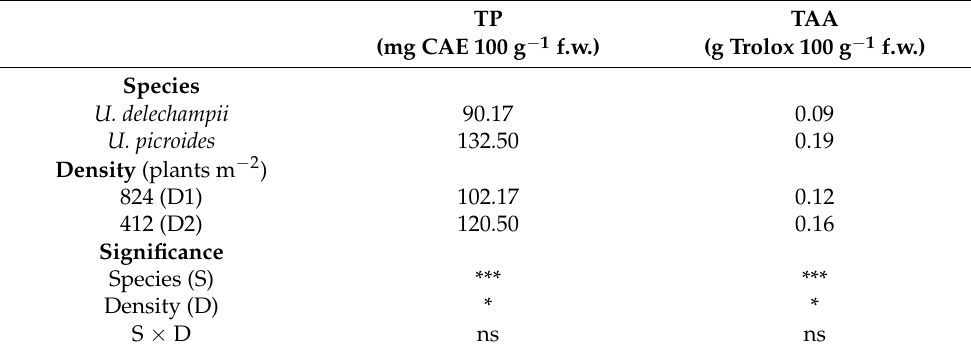
Table 7. Total phenols (TP) and total antioxidant activity (TAA) of smooth golden fleece ( U. delechampii ) and prickly golden fleece ( U. picroides ) grown in a floating system at two differ- ent sowing densities (second harvest). TP TAA (mg CAE 100 g − 1 f.w.) (g Trolox 100 g − 1